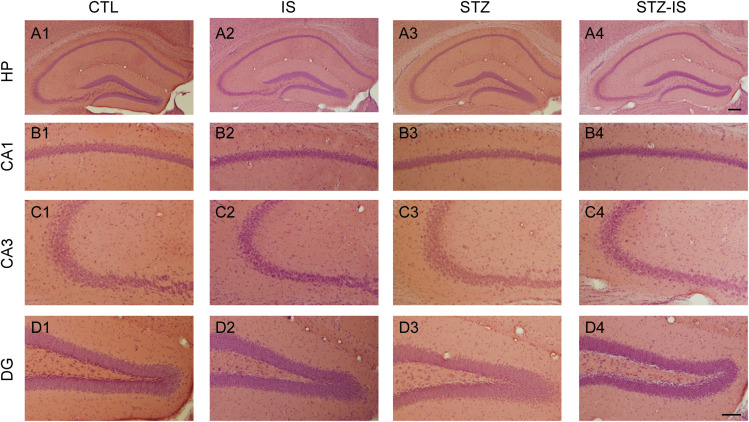
Histology of the hippocampus in different experimental conditions. Representative photographs show H&E staining of brain sections of CA1, CA3, and DG in control (CTL), ischemia (IS), diabetes and diabetes-ischemia (STZ) mice. No apparent cell death was observed in the hippocampus 12 h after ischemia in normoglycemia and diabetic mice. The scale bar of (A4) (200 μm) is equal to (A1–A3). And the scale bar of (D4) (100 μm) is equal to (B1–D3).